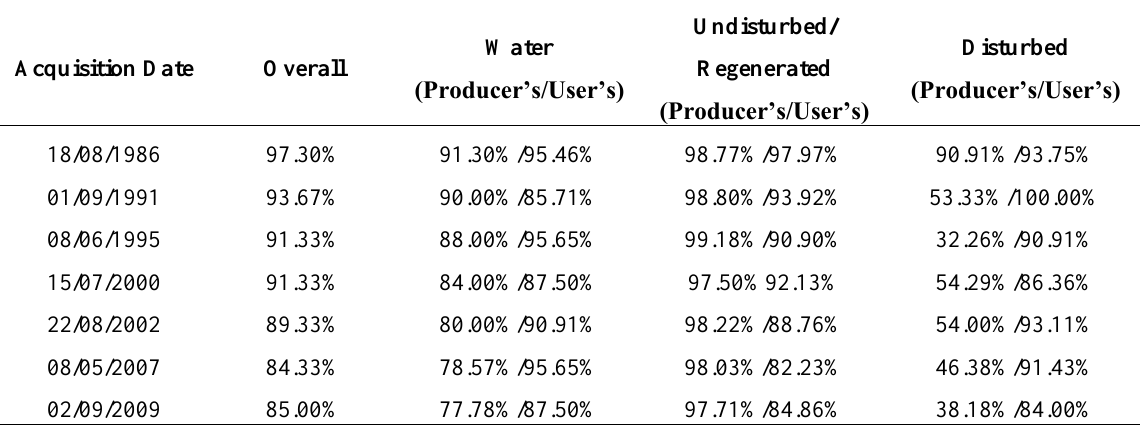
Table 2. Classification Accuracy Statistics for all Image